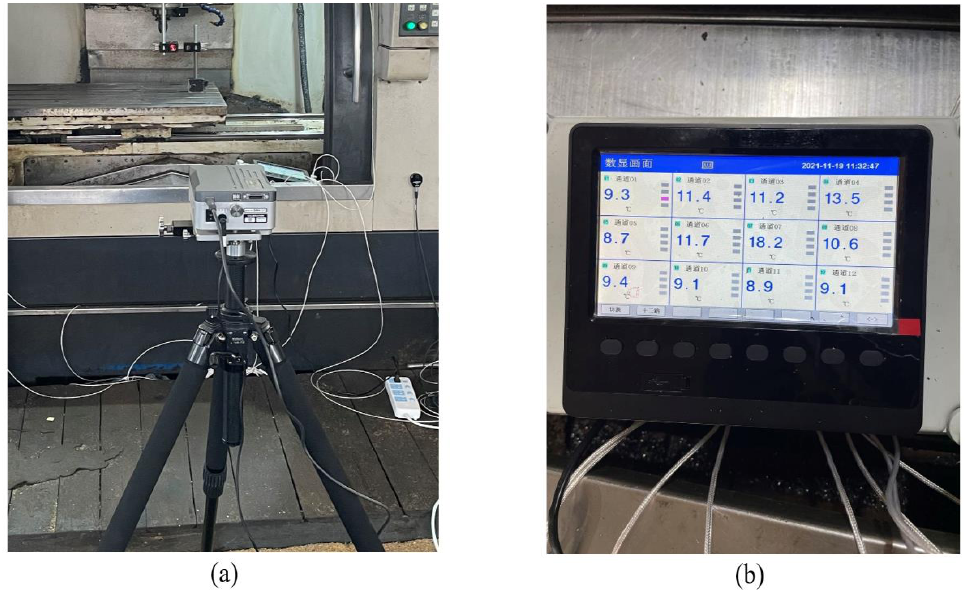
Figure 8. Data acquisition instruments: ( a ) the laser interferometer, ( b ) the paperless recorder. To ensure the generalization and accuracy of the model, it was necessary to collect machine tool temperature data and thermal error data under different working condi- tions [35]. During the experiment, the machine tool data at three speeds were collected, that is, three sets of thermal error experiments were carried out in total. In the first set of experiments, starting from the cold state of the machine tool at time 0, we set the X-axis of the machine tool to perform linear motion at a feed speed of 2000 mm/min and let the machine tool run continuously for 4 h without load, which was recorded as V 1 = 2000 mm/min. In the second set of experiments, the machine tool still started from a cold state, and the feed rate of the X-axis of the machine tool was set to 5000 mm/min for linear mo- tion; the machine tool ran continuously without load for 4 h, which was recorded as V 2 = 5000 mm/min. In the third set of experiments, other conditions remained unchanged: the machine tool still started from a cold state, the X-axis feed rate was set to 8000 mm/min, and the machine tool was also allowed to run continuously for 4 h without load, which was recorded as V 3 = 8000 mm/min. The temperature and thermal error data were rec- orded during each experiment every 1 min. In this way, 240 sets of data samples were obtained for each set of experiments. The collected temperature rise data and thermal er- ror data under three working conditions are shown in Figures 9 – 12.